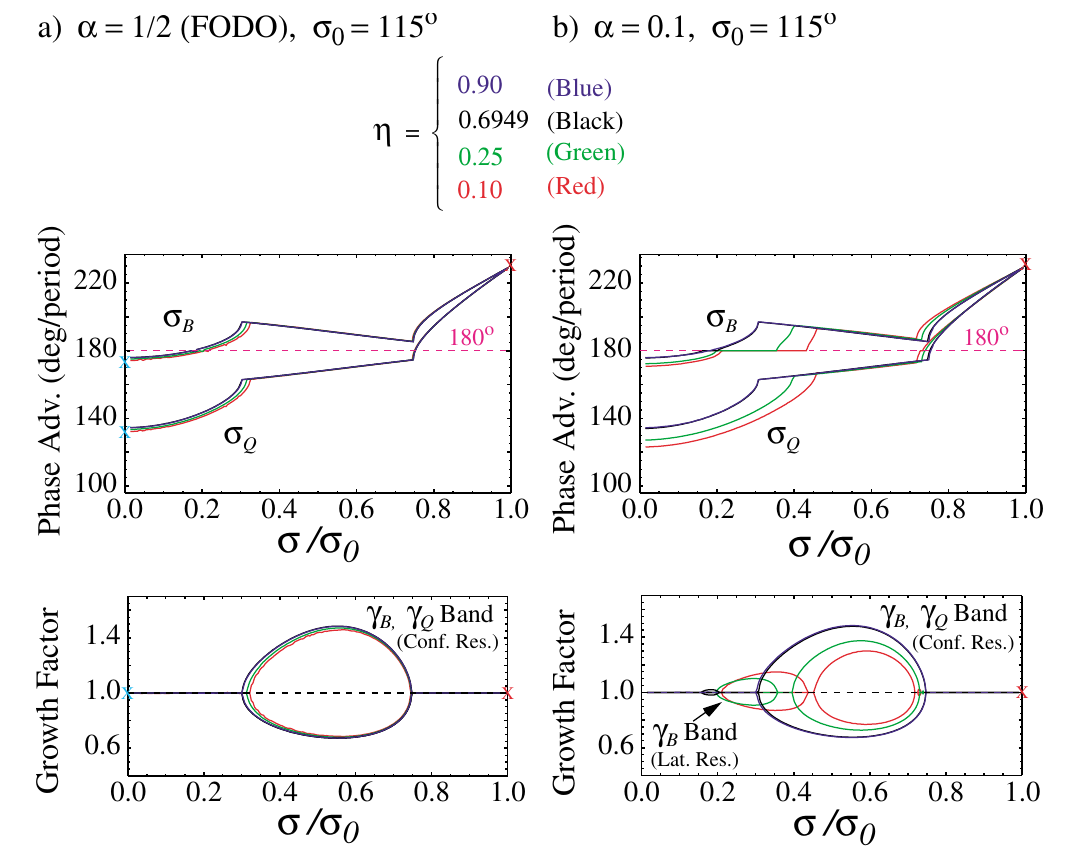
FIG. 18. (Color) Variation of mode structure with quadrupole occupancy (cid:31) and syncopation factor # . Phase advance ( (cid:24) and (cid:6) ) of the breathing and quadrupole modes are plotted versus (cid:24)=(cid:24) and growth factors ( (cid:6) B Q values of (cid:31) . Results are contrasted in (a) and (b) for # (cid:1) 1 = 2 (FODO) and # (cid:1) 0 : 1 (strong syncopation). Red (cid:22) s mark analytical results in the zero space-charge limit, and cyan (cid:22) s mark thin-lens limit ( (cid:31) ! 0 ) analytical results for a FODO focusing with (cid:1) 0 (cid:24)=(cid:24) 0